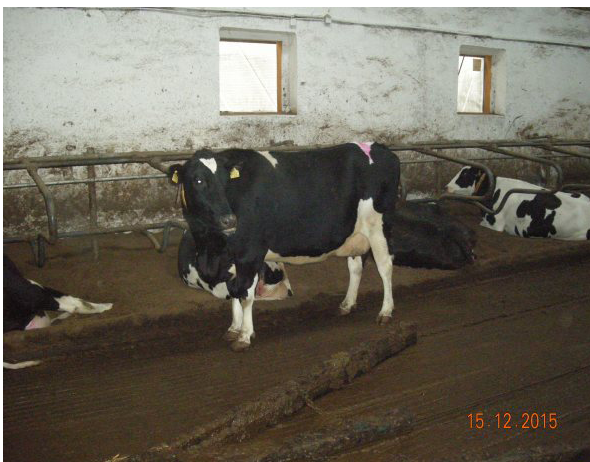
Figure 1. A cubicle bedded with DMS.